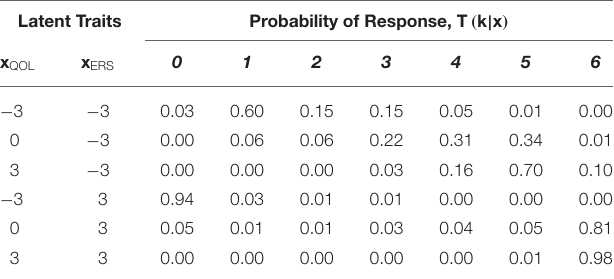
(e.g., k = 1 and k = 5), become more dominant response options as ERS decreases (For two-dimensional slices of such plots, see Falk and Cai,